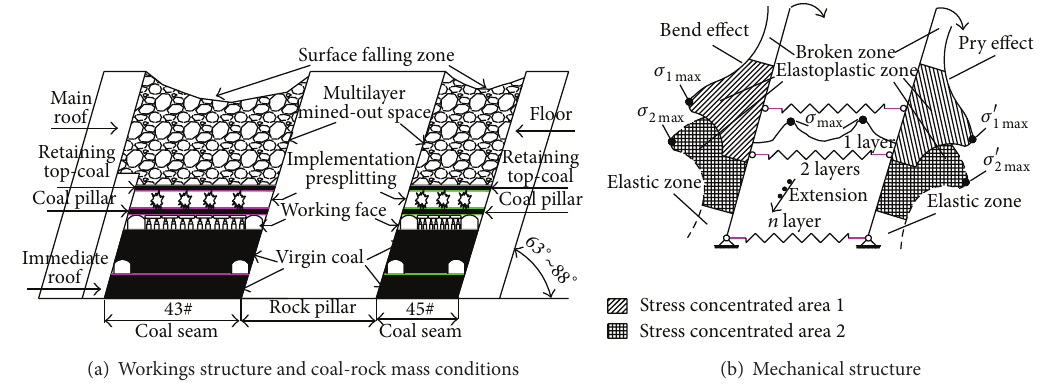
Figure 3: Descriptions of the structure with the steep-coal-seam working